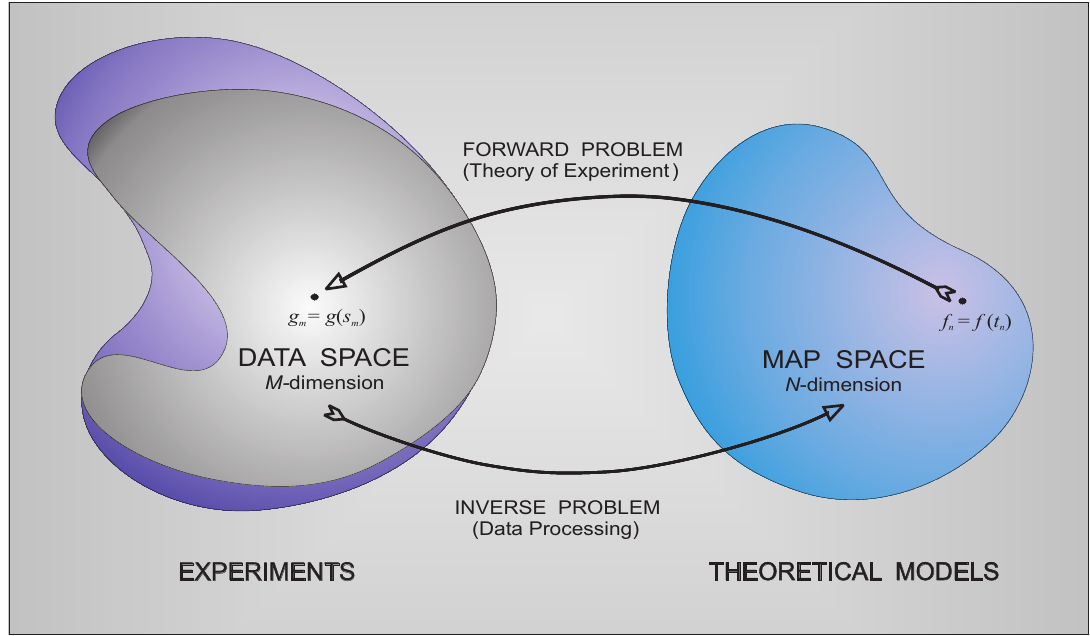
Figure 1. Flow chart of the inverse and forward